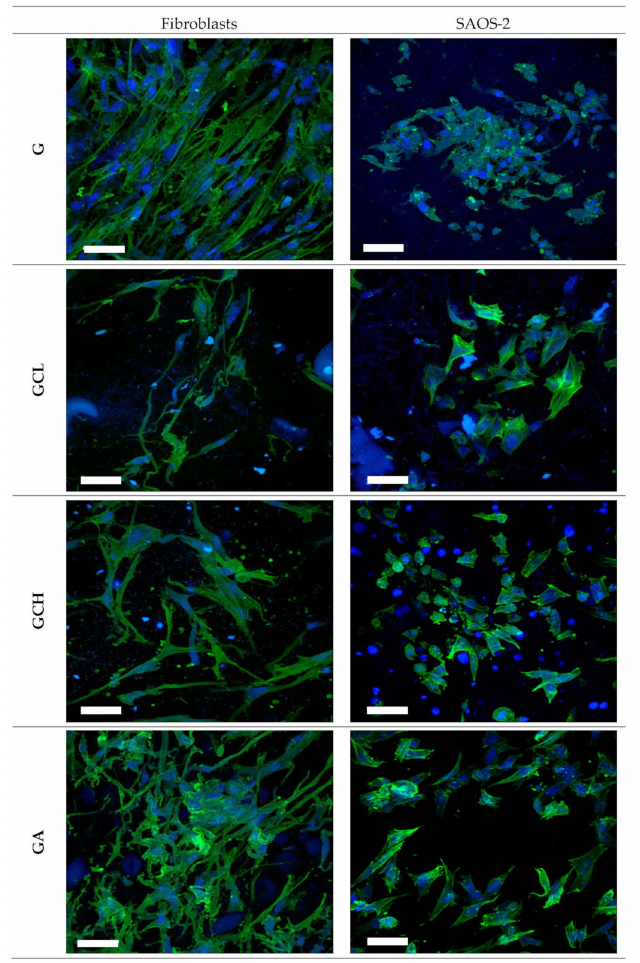
Figure 8. Confocal laser scanning microscopy (CLSM) (scale bar: 50 µ m) images of fibroblasts and SAOS-2 grown for 6 days onto the scaffolds (in blue: nuclei; in green: